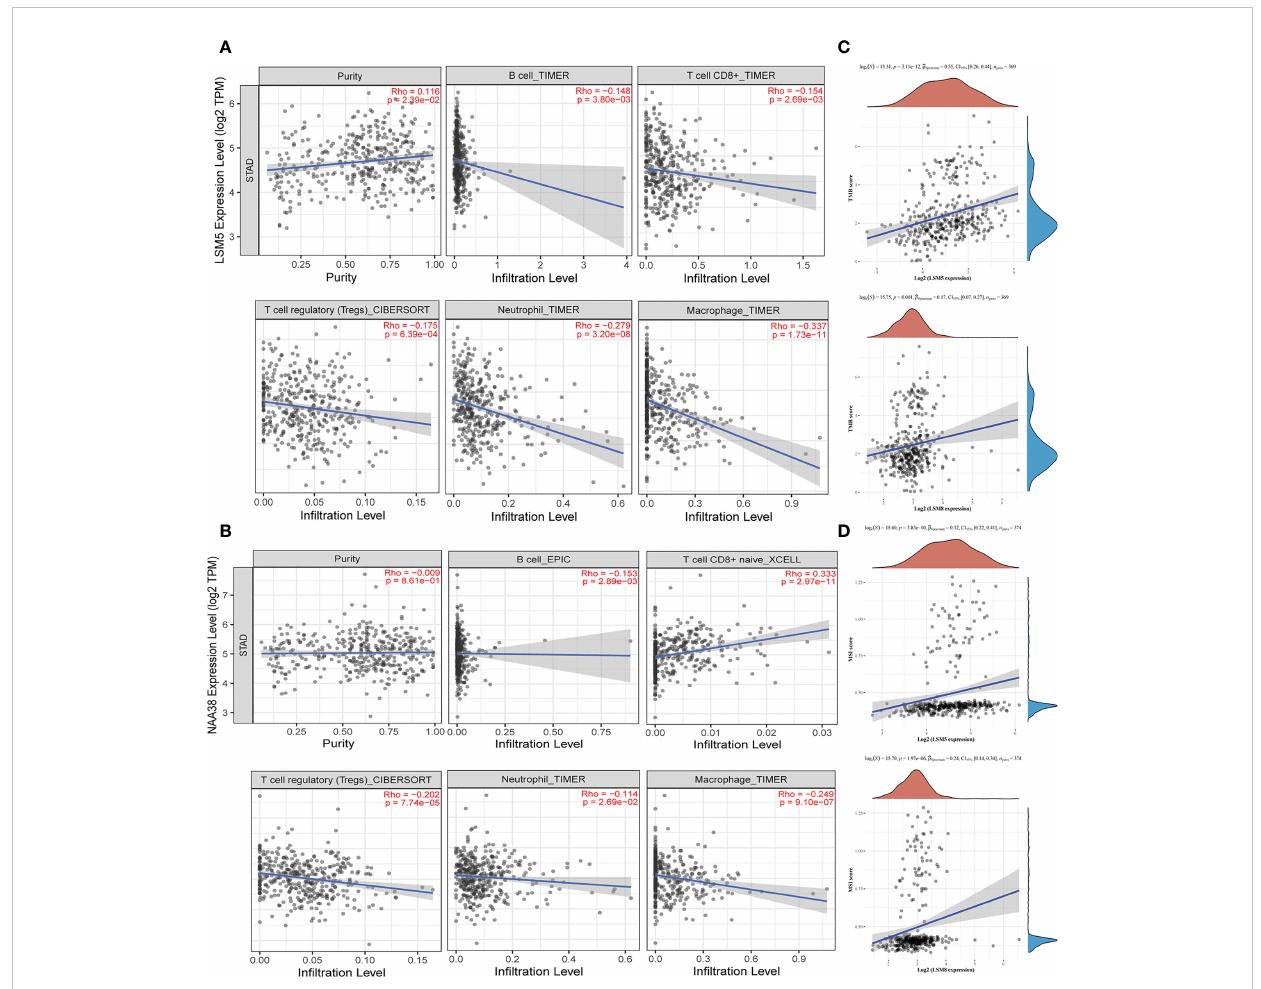
FIGURE 7 The status of tumor microenvironment for LSM5 and LSM8 in GC. (A, B) Correlations between the abundance of immune cells and the expression of LSM5, LSM8 by TIMER analysis (https://cistrome.shinyapps.io/timer/). (C) The expression of LSM5 and LSM8 positively correlated with TMB in GC from TCGA database. (D) The expression of LSM5 and LSM8 positively correlated with MSI in GC from TCGA